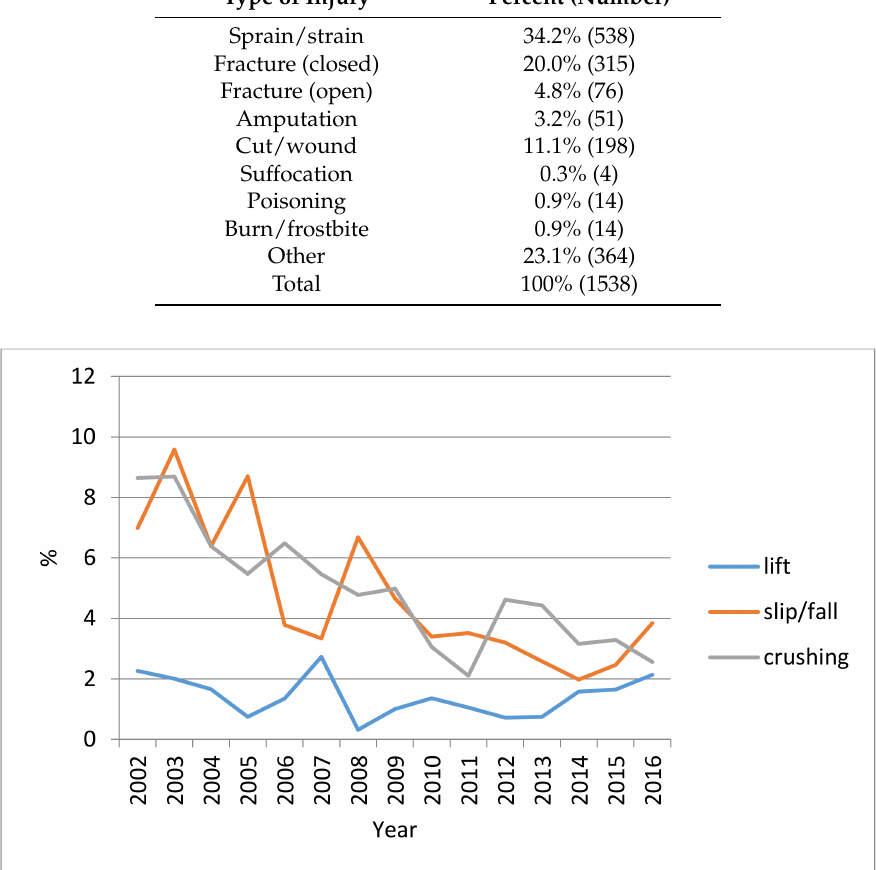
Figure 8. The rate (per 1000 fisherman) of three types of incidents causing injuries